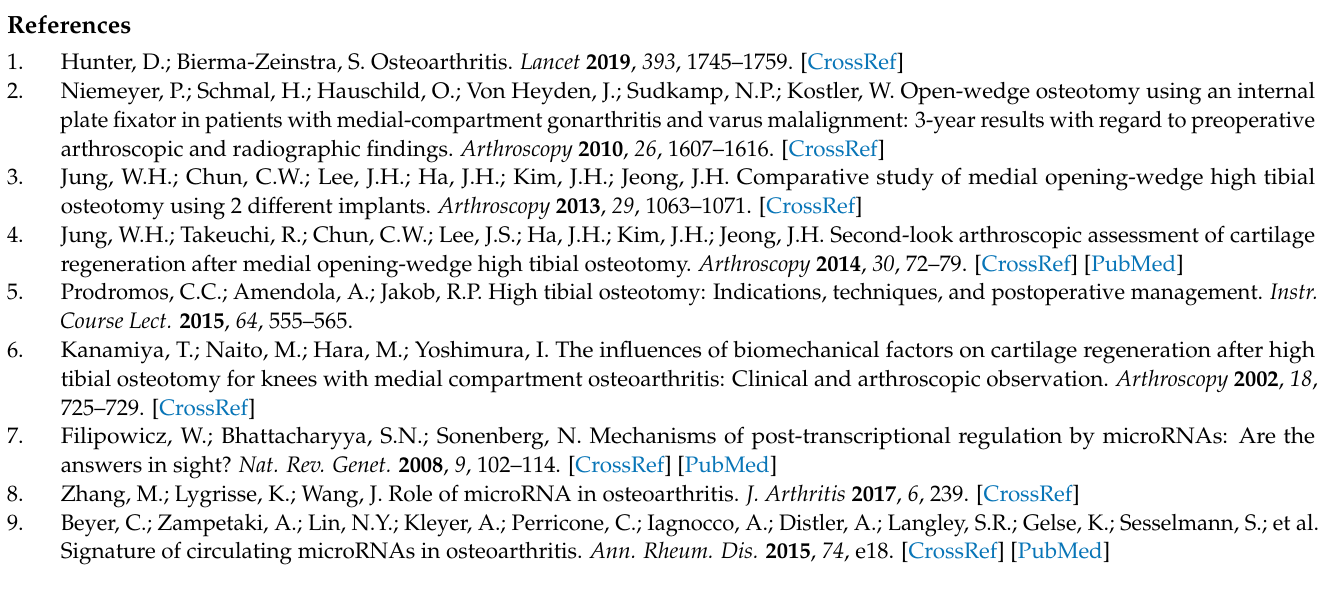
Figure S1: Raw data of miR-19b-3p (A), miR-29c-3p (B), miR-424-5p (C), miR-140-3p (D),